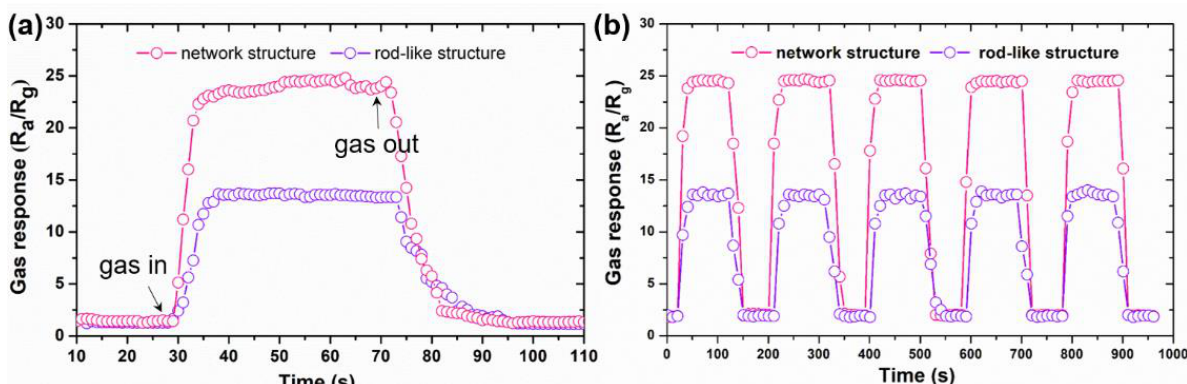
Figure 5. ( a ) The dynamic response and recovery curves of the network and rod-like WO 3 ·H 2 O-based gas sensors towards 50 ppm H 2 S at 300 °C. ( b ) The cycling response and recovery curves of the network and rod-like WO 3 ·H 2 O-based gas sensors towards 50 ppm H 2 S at 300 °C.